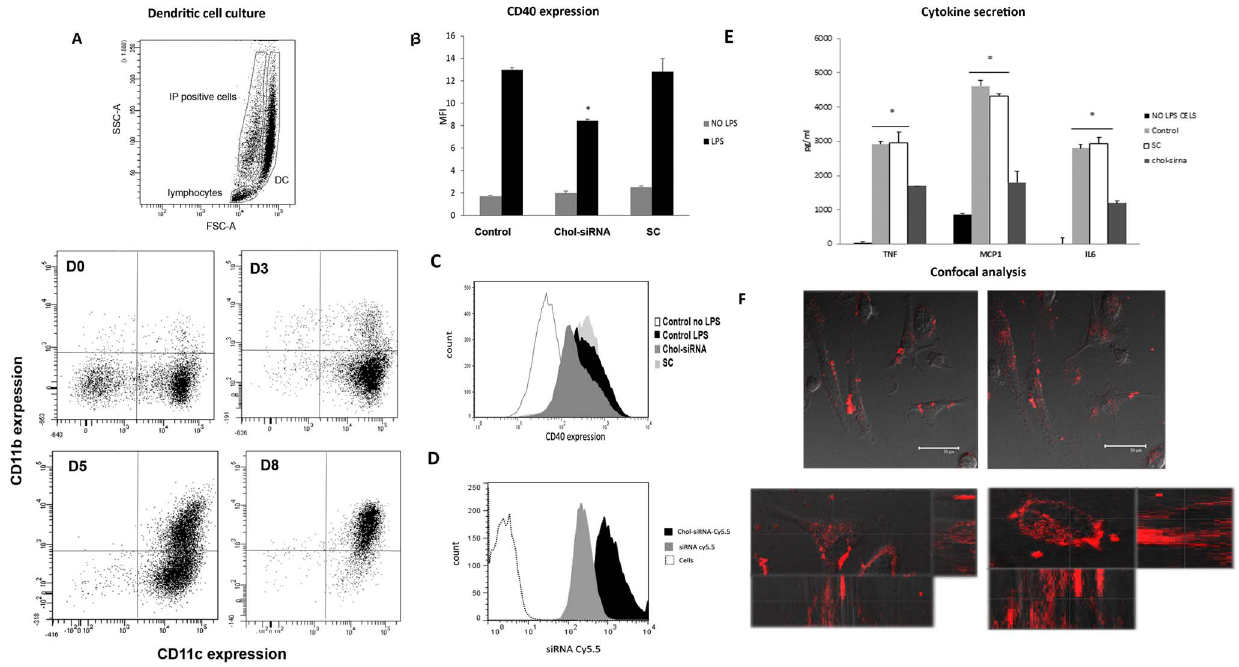
Figure 1. Representative flow cytometry analysis of DC culture. A) DC culture development. Lymphocytes (CD3 + ) and death cells (IP positive) were discarded. DCs were backgated using a FSC-A/SSC-A dot plot. Subsequently, CD11c and CD11b expression were assessed in DC population using CD11c APC/CD11bPE dot plot. D0, D3, D5 and D8=day 0, 3, 5 and 8 respectively B) CD40 expression of DC with and without LPS stimuli and transfected with Chol-siRNA or SC siRNA were analyzed by flow cytometry (MFI). *p , 0.05 vs control and scrambled. C) Representative histograms for each group of treatment. D) Representative histograms of siRNA internalization analyzed by flow citometry (MFI). E) DC cytokine secretion after LPS stimulus and Chol-siRNA effect. F) Chol-siRNA Cy5.5 internalization in DCs is shown at time 0 and after 45 min of incubation (upper left and right photomicrograph x630, respectively). Middle and bottom photomicrographs: Z-scan image of live DC cells where we can observe siRNA cytoplasm localization and confocal projections of the cell to the xz and zy planes (sideviews). Data are expressed as mean 6 SEM of four separate experiments.